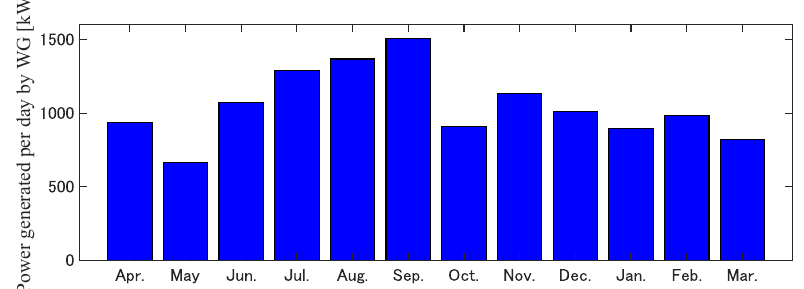
Figure 3. Daily generation of WG with a rated output of 250 kW by